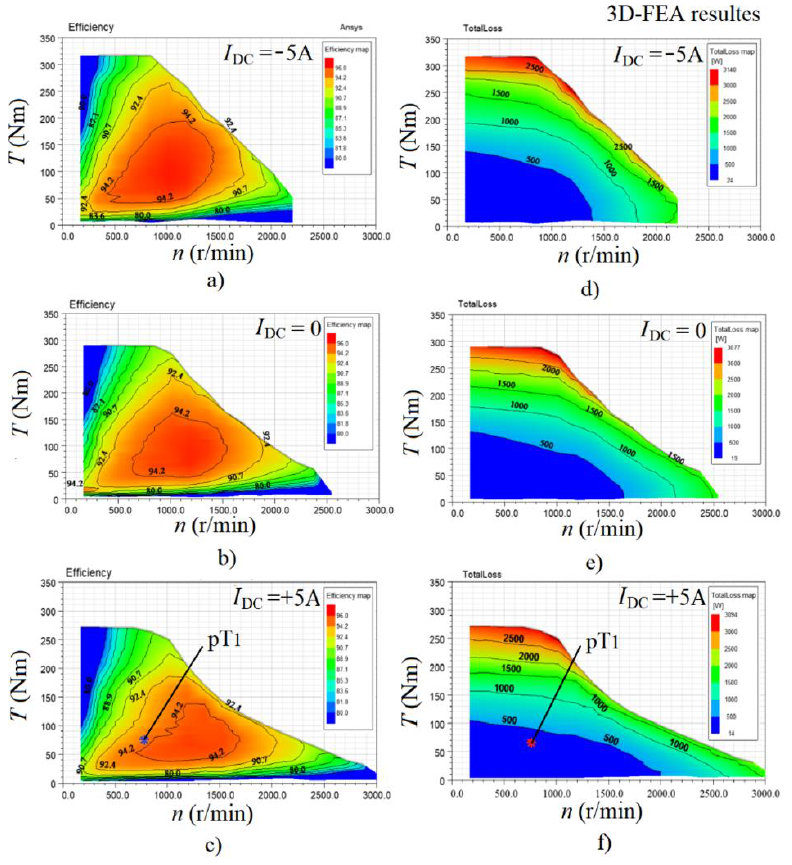
Figure 10. Maps of machine efficiency ( a – c ) and total losses ( d – f ) for three I DC current excitations.